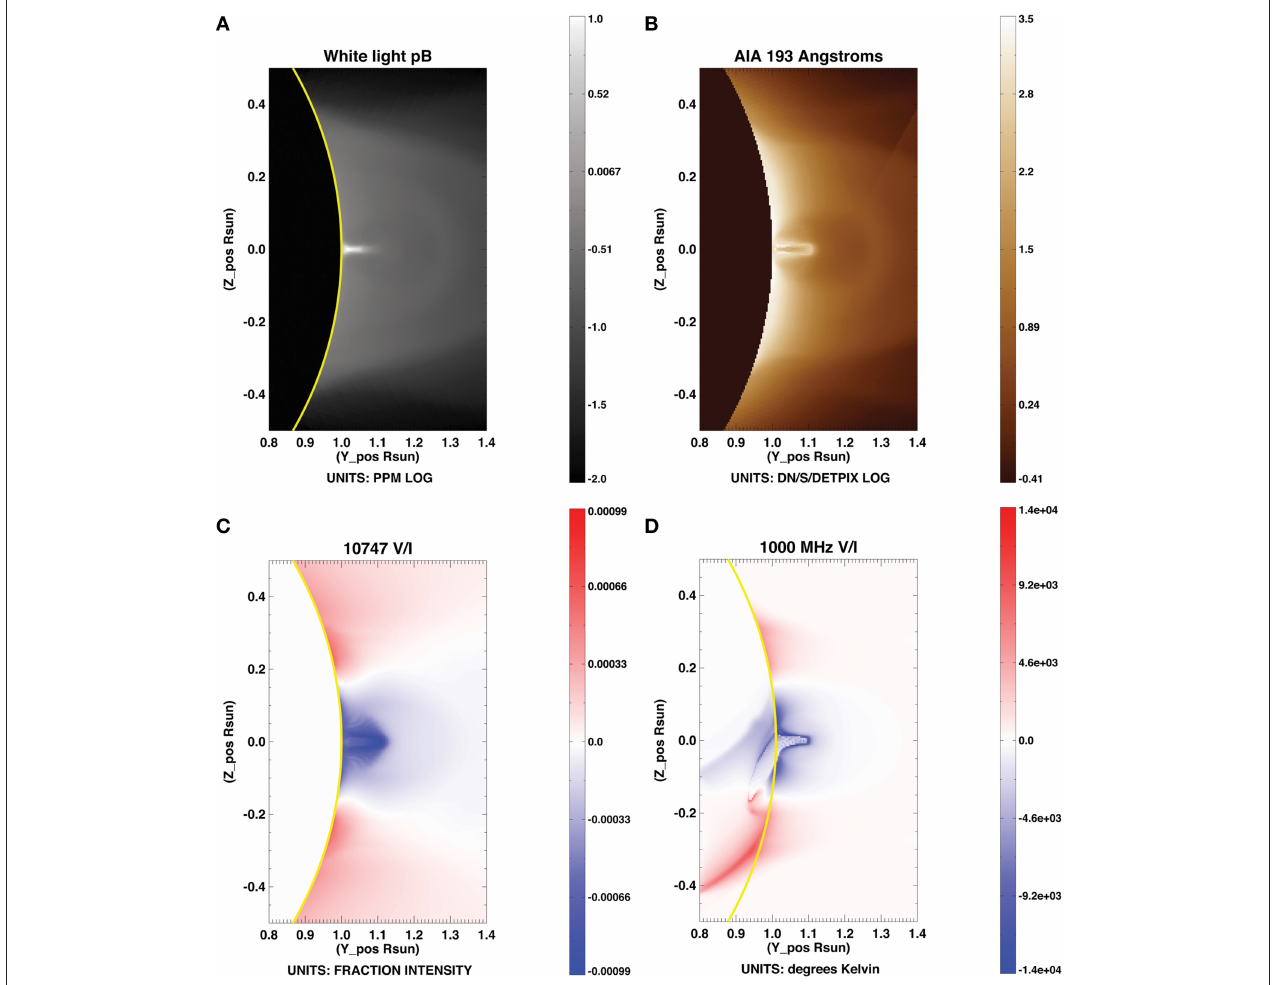
FIGURE 14 | Synthetic data including (A) visible and (B) EUV intensity, and (C) IR and (D) radio circular polarization, generated for simulated prominence-cavity system (Fan, personal communication). Plot (A) obtained by FORWARD line command: for_drive,'numcube',cubename='$FORWARD_ DB/TESTBEDS/fullthermodynamic_erupting_qp_mhd_Fan',xxmin=0.8,xxmax=1.4,yymin=-.5,yymax=.5,units='PPM',cuberot=-25., colortable=0 . Plot (B) obtained with addition of keyword /aia . Plot (C) added with addition of keyword /comp,line='VOI' , and (D) with addition of /radio,line='VOI'